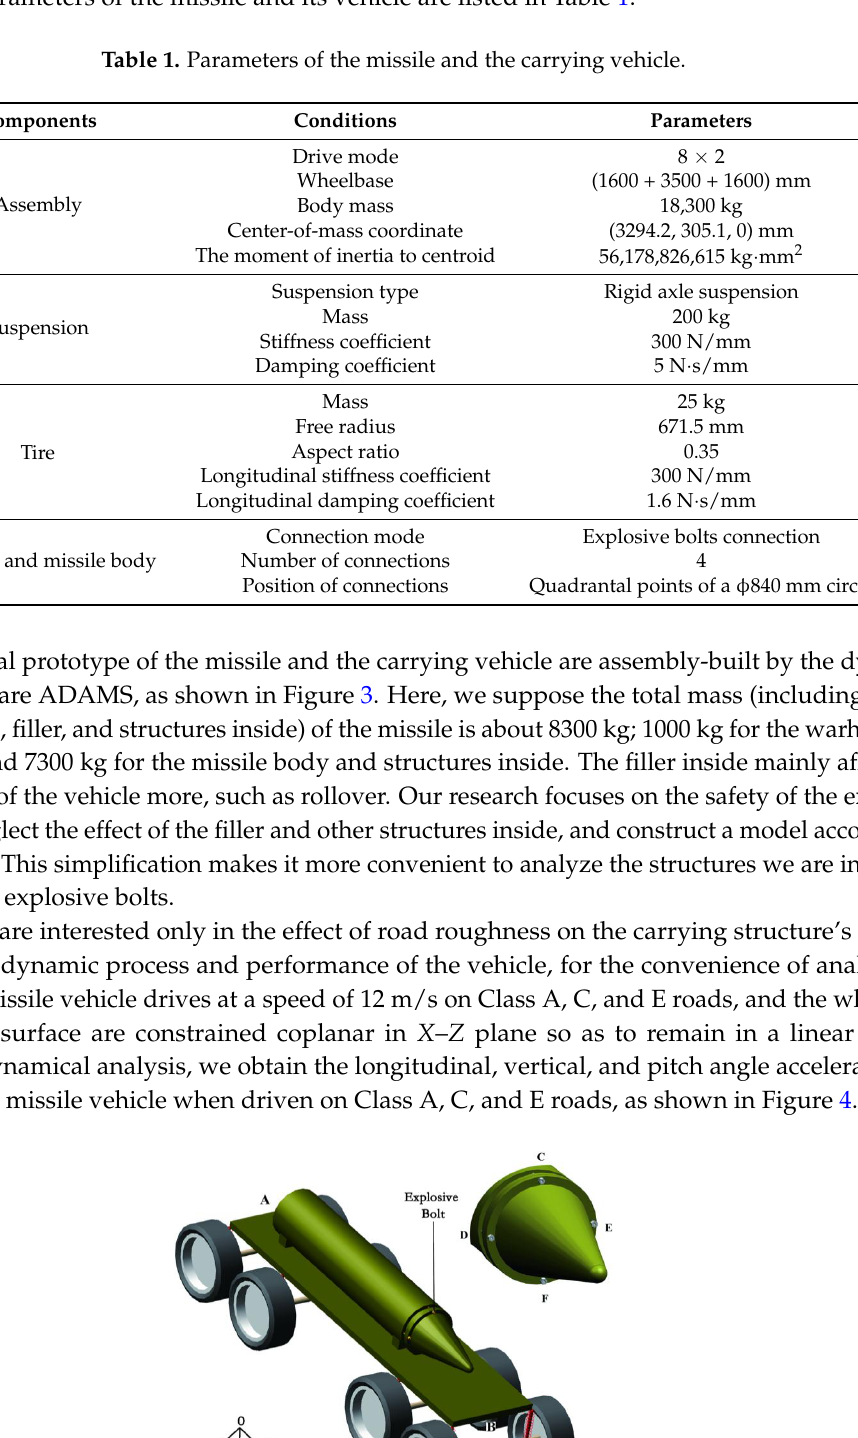
Table 1. Parameters of the missile and the carrying vehicle.